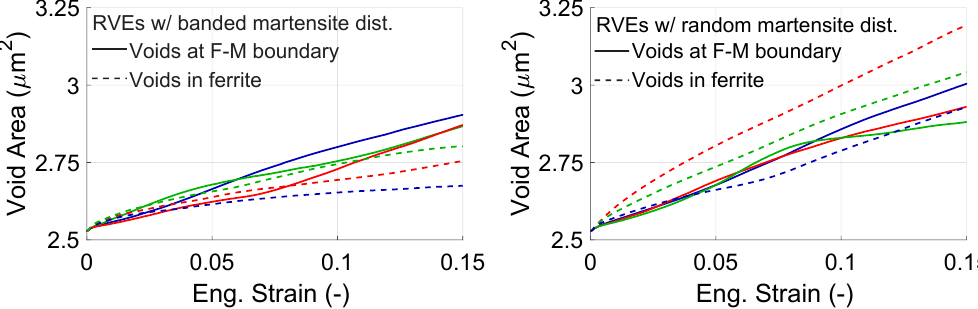
Figure 11. Evolution of total area of voids ( left ) banded, ( right ) random morphology for 3 orientation sets with total strain. Each color represents an orientation